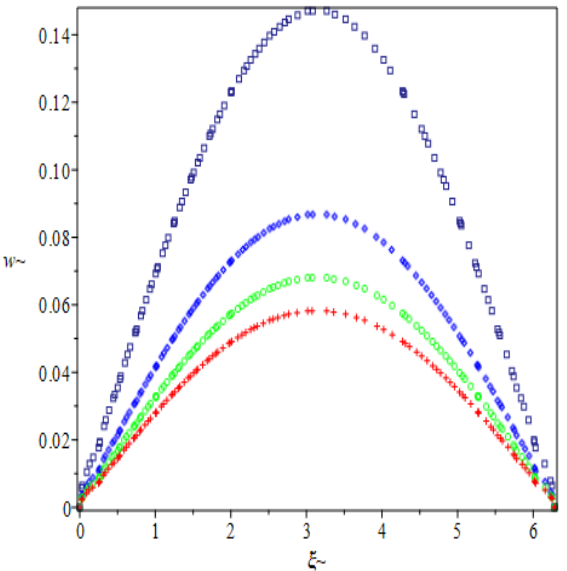
Figure 6. Dimensionless coordinates show the dependence, in the bandwidth adjacent to 0, for the dimensionless frequency on the wave number for different values of water concentration. Table 1. This table contains a description for Figure 6. Concentration k of Water in Air for Symbol on the Monodisperse Phonon Crystals